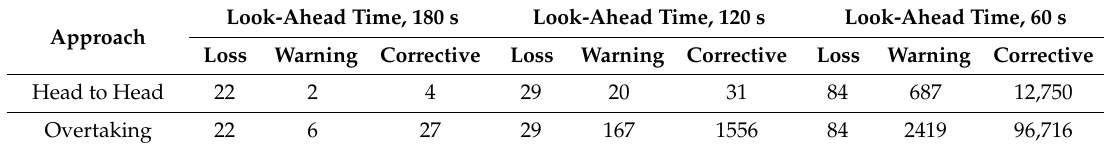
Table 6. Total drop-out affected alert triggered in different look-ahead time out of n = 10 5 runs.